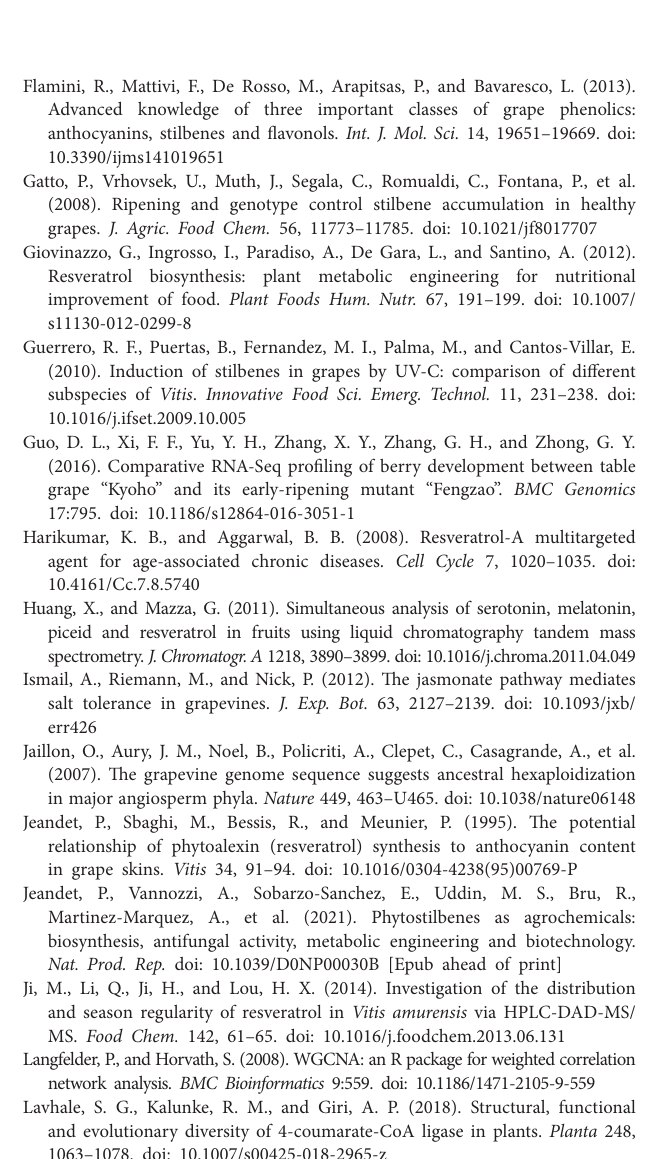
Supplementary Figure S1 | Kyoto Encyclopedia of Genes and Genomes (KEGG) pathway of gene enrichment analysis. Supplementary Table S1 | Primer sequences of